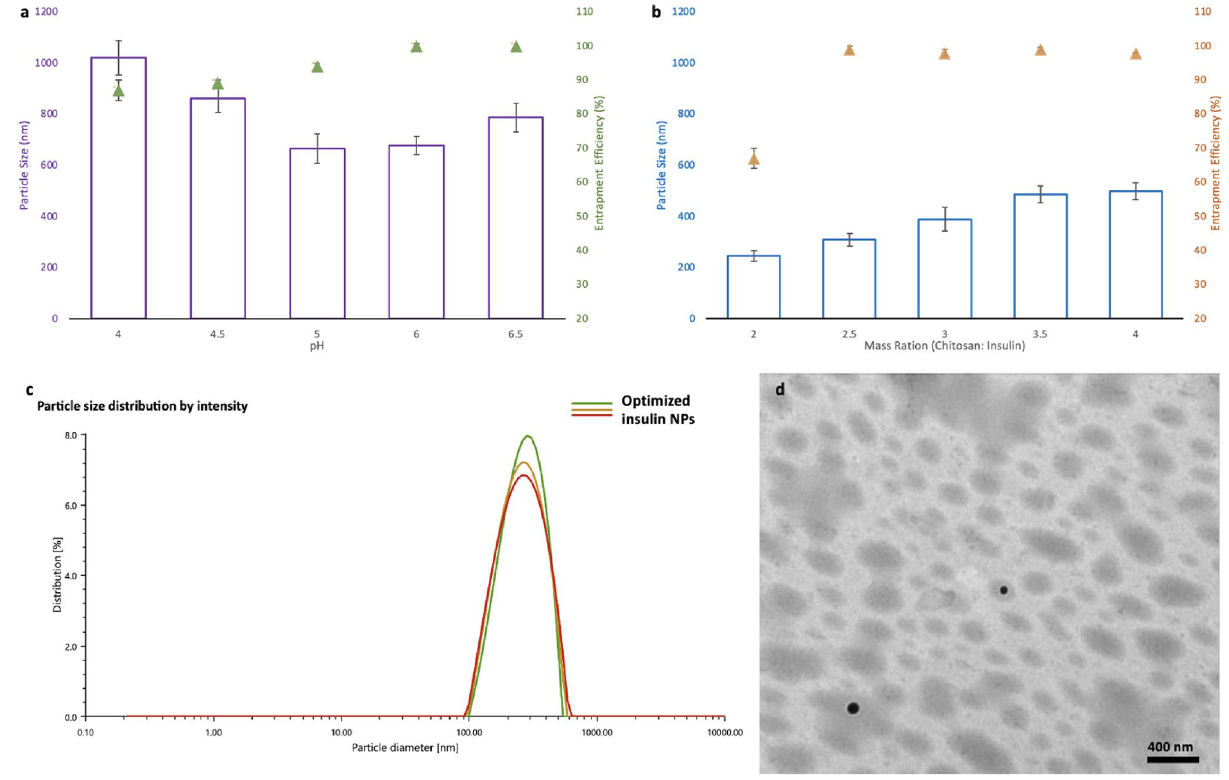
Figure 1. Optimization of parameters for insulin NPs: ( a ) Effect of the pH on the average diameter and the encapsulation efficiency (EE) of the insulin NPs (prepared under the mass ratio of chitosan and insulin at 5:1); ( b ) Effect of the mass ratio between chitosan and insulin the average diameter and the encapsulation efficiency (EE) of the insulin NPs (prepared at pH 6); ( c ) Particle size distribution of the optimized insulin NPs; ( d ) TEM micrographs of the optimized insulin